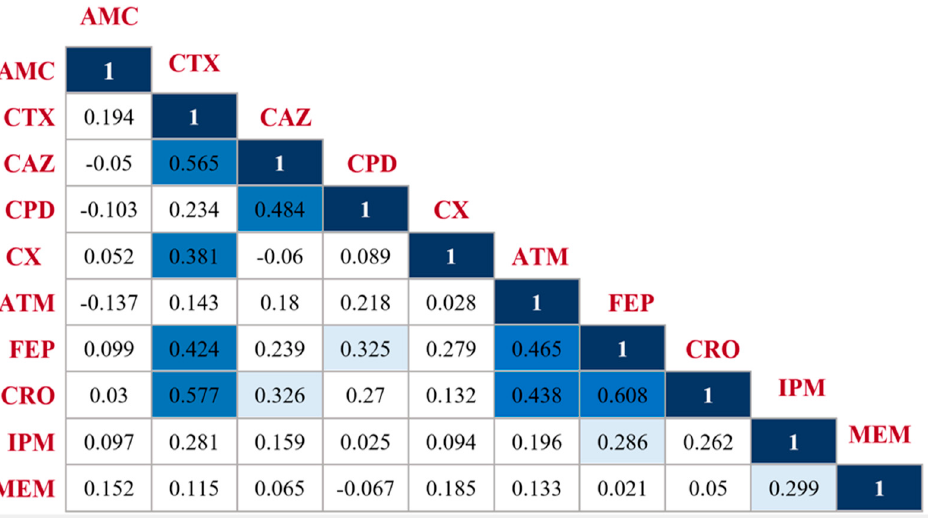
Figure 2. Correlation matrix showing Pearson’s correlation coefficients (r) for each pair of β -lactam antibiotics, calculated according to the resistance patterns of 48 tested E. coli isolates. Light-blue-colored boxes illustrate correlations that are significant at the 0.05 level, while dark-blue-colored boxes illustrate significant correlations at the 0.001 level. Abbreviations: AMC: amoxycillin/clavulanate, CTX: cefotaxime, CAZ: ceftazidime, CPD: cefpodoxime, ATM: aztreonam, CRO: ceftriaxone, FEP: cefepime, CX: cefoxitin, IPM: imipenem, and MEM: meropenem.